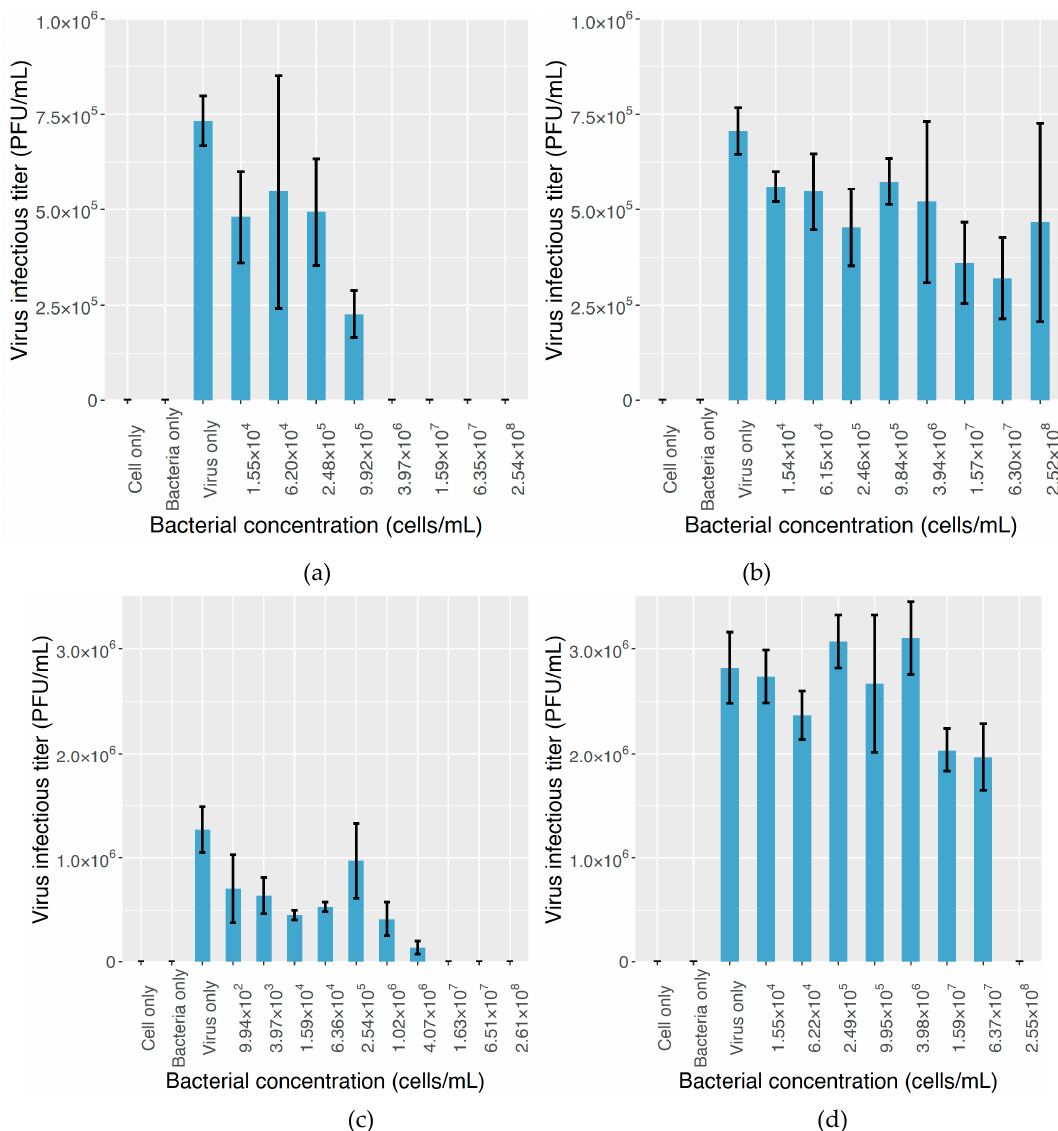
Figure 4. The plaque assay results for the inhibitory e ff ect of bacterial cells on MNV infectivity. The mixture of bacteria and virus suspension was directly added to RAW cell culture without centrifugation. The extent of the inhibitory effect is demonstrated by the drop in infectious titer as the bacterial content increases. ( a ) MNV-1 mixed with S. maltophilia B4. ( b ) MNV-1 mixed with C. massiliae F5. ( c ) MNV S7 mixed with S. maltophilia B4. ( d ) MNV S7 mixed with C. massiliae F5. In the experiment,